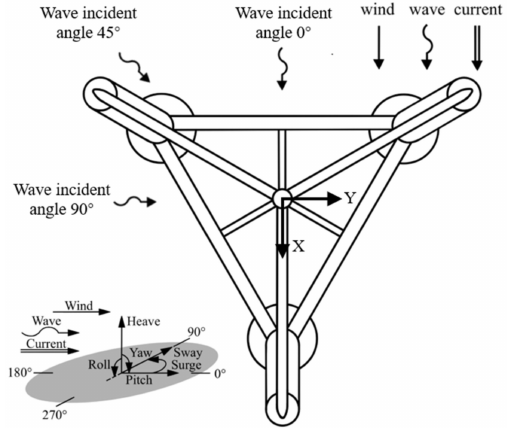
Figure 8. Global coordinate system and wind, wave, current direction definition.